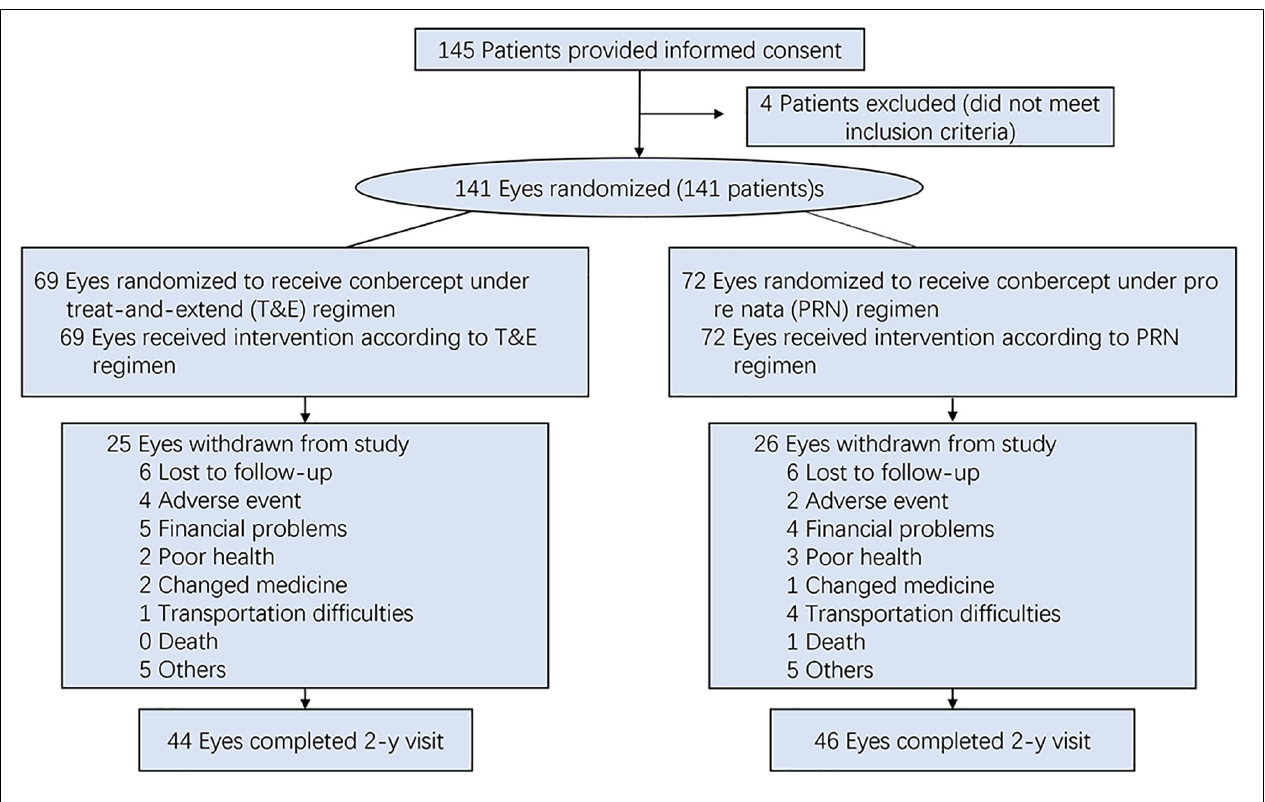
FIGURE 1 | The flowchart of the